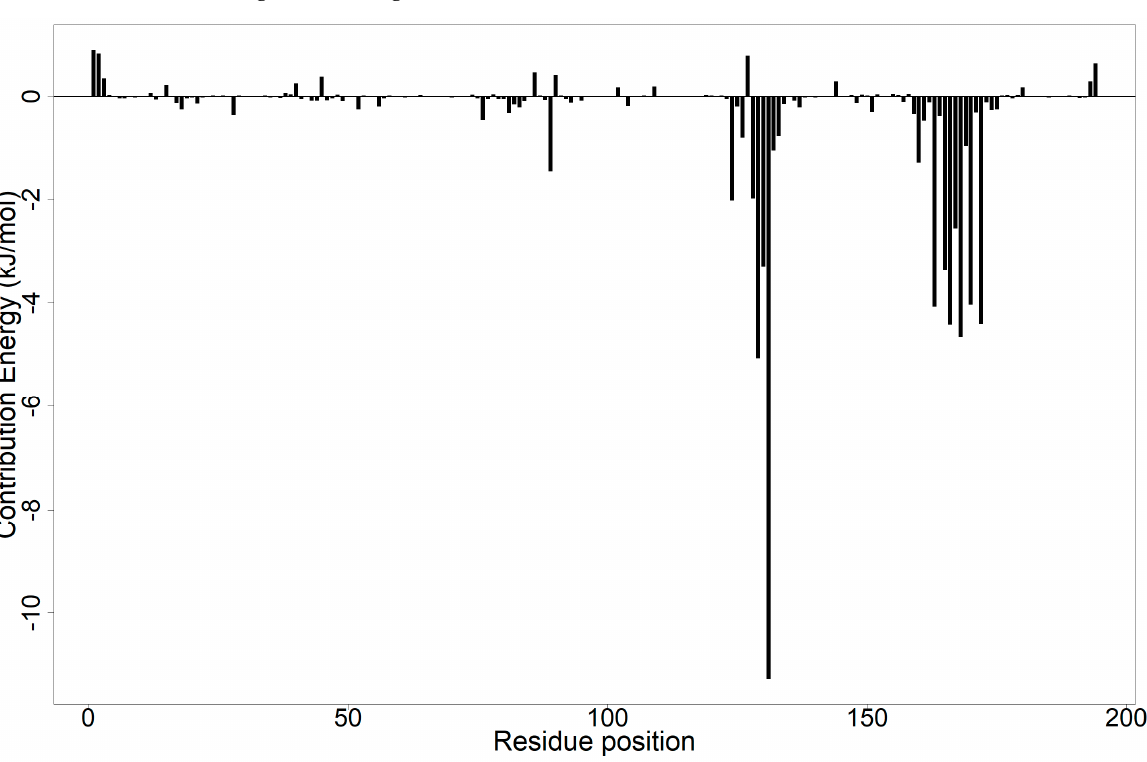
Figure 6. Per-residue energy decomposition plot of the VP40–NANPDB2933 complex showing the energy contributions of each amino acid residue.